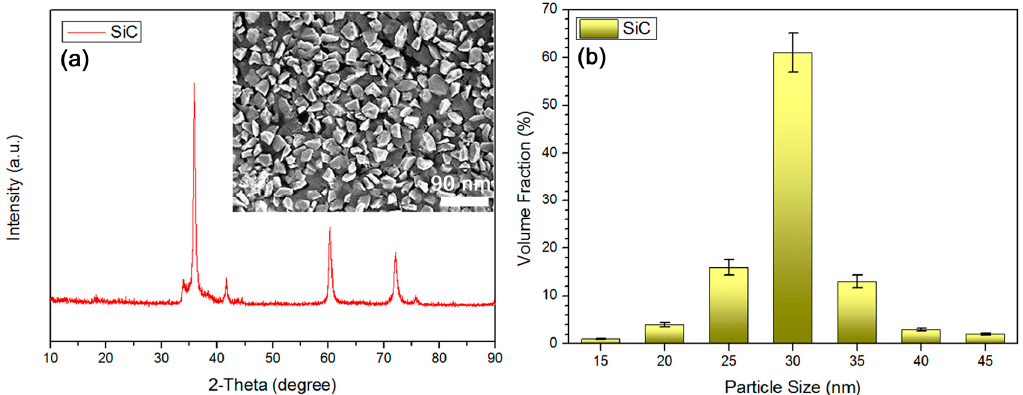
Figure 1. ( a ) X-ray diffraction (XRD) confirmed beta crystalline form for SiC, SEM (inset) verified high geometrical asymmetry for SiC, and ( b ) particle size distribution histogram suggested 30 nm as average particle size and a narrow particle size distribution for SiC.